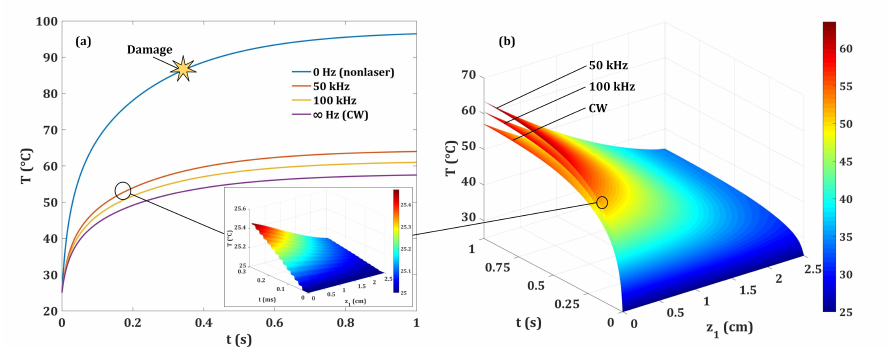
Figure 7. The temporal evolution of ( a ) maximum temperature in Xtal 1 at CW, 100 kHz Q-switched, 50 kHz Q-switched and nonlaser conditions; ( b ) temperature distribution in Xtal 1 along the z -axis at CW, 100 kHz Q-switched and 50 kHz Q-switched conditions.